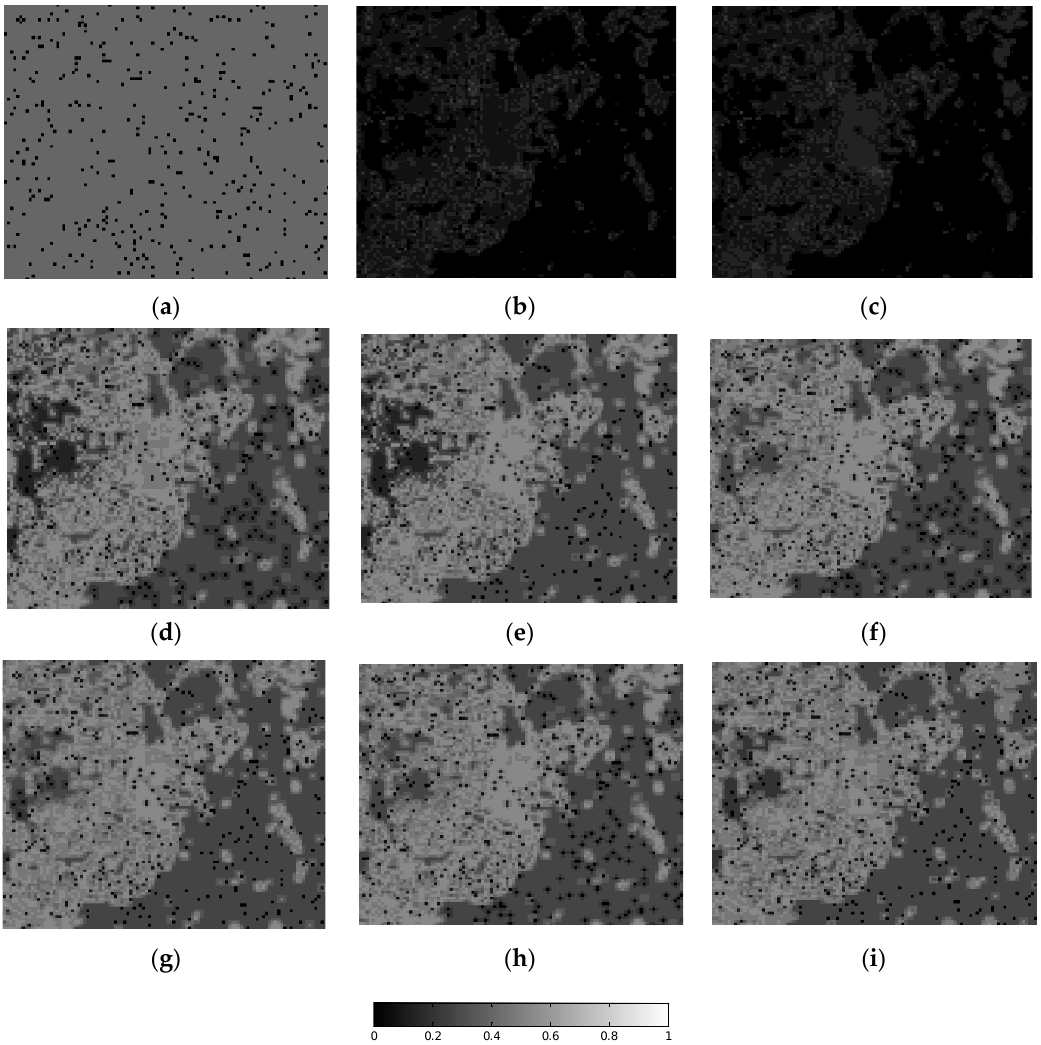
Figure 4. Maps of prediction standard errors for different methods (the same set of methods as listed in Figure 3): ( a ) indicator kriging; ( b , c ) logistic regression, without and with spatial correlation considered, respectively; ( d , e ) logistic regression and kriging, without and with spatial correlation considered in regression, respectively; ( f , g ) logistic regression (without considering spatial correlation) and kriging, with extra training samples collected by random and adaptive sampling, respectively; ( h , i ) logistic regression (considering spatial correlation) and kriging, with extra training samples collected by random and adaptive sampling,